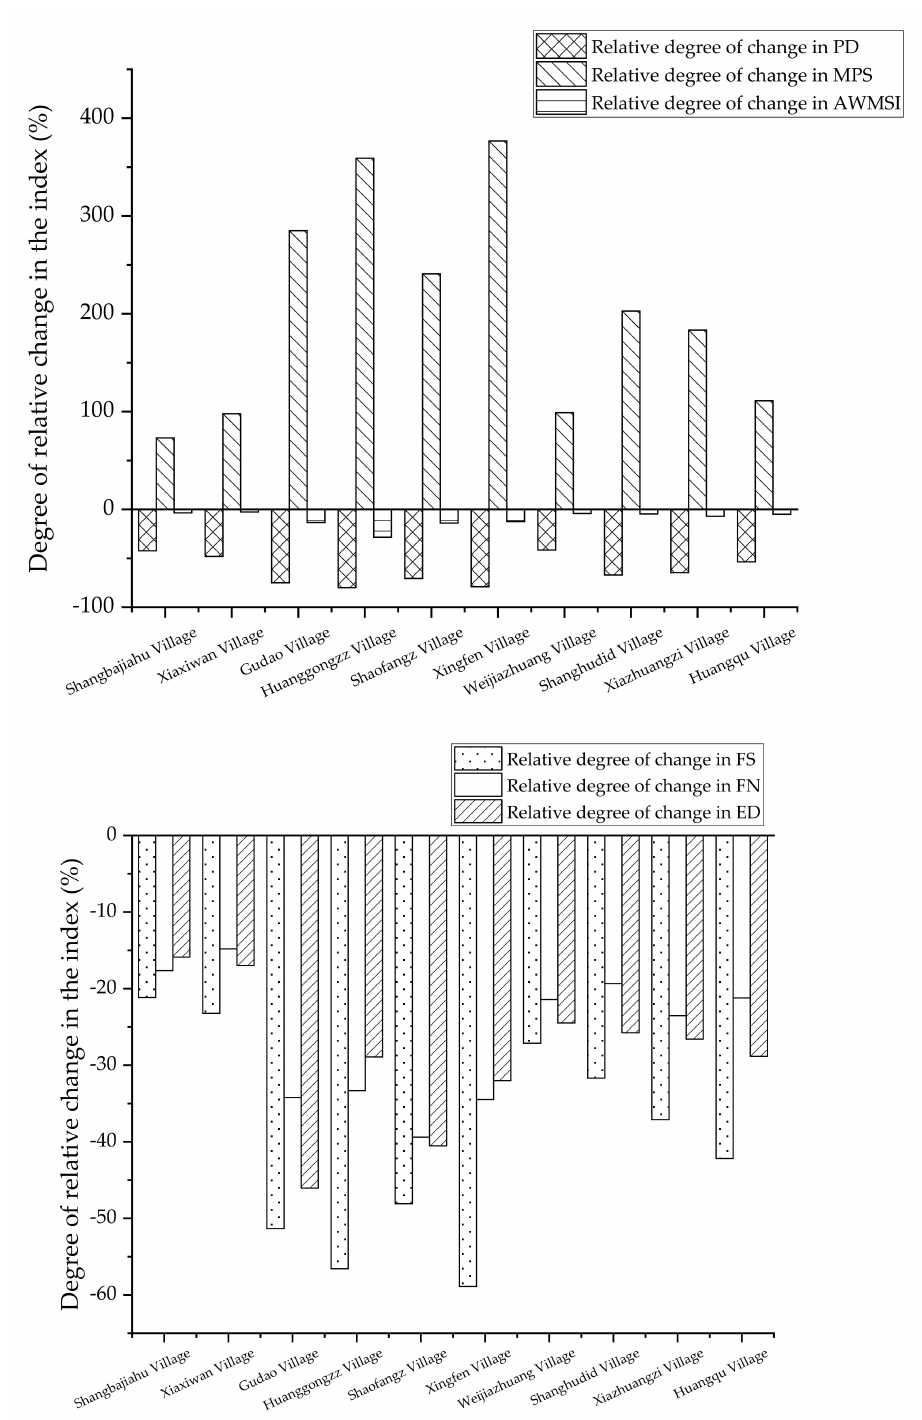
Figure 2. Changes in the degree of fragmentation in each